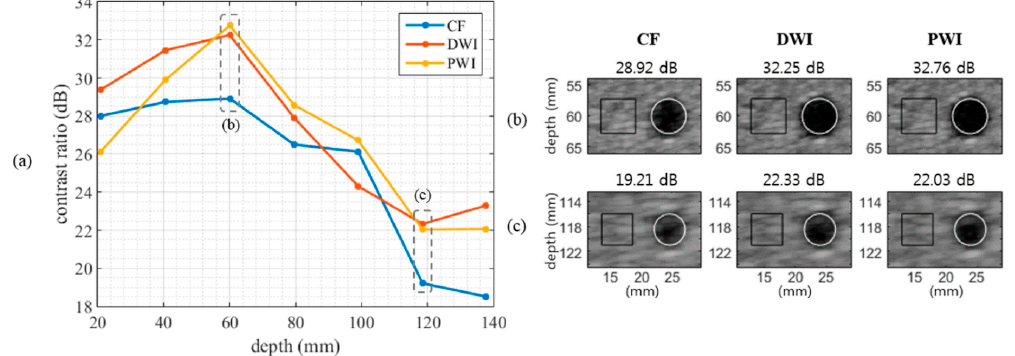
Figure 4. ( a ) Contrast ratio (dB) over all depths measured from cyst targets in the phantom images of CF, DWI, and PWI. The contrast ratio of CF is lower than those of DWI and PWI on average. ( b , c ) Magnified cyst target images of Figure 2 at depths of ( b ) 60 mm and ( c ) 120 mm. The black square and the white circle show the contrast measurement areas. The measured contrast ratio is presented above each panel.